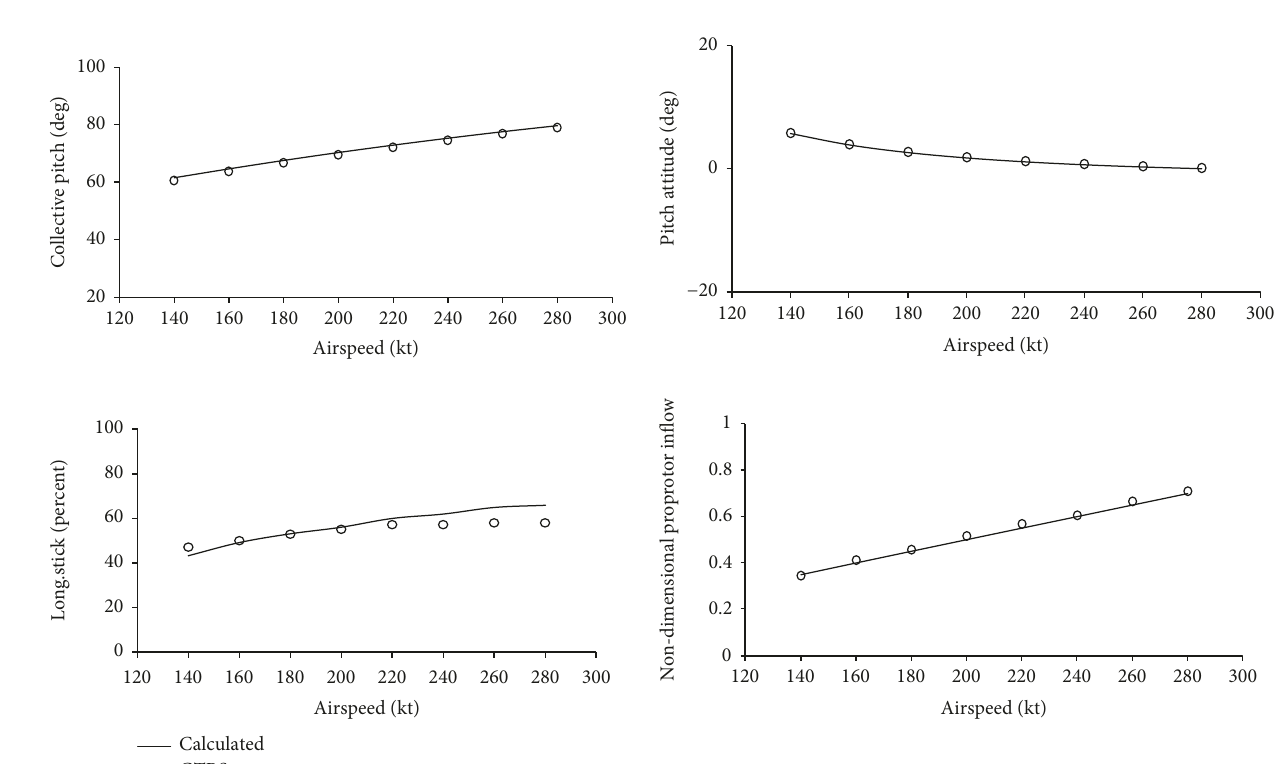
Figure 6: Trim results in nacelle 30 deg.